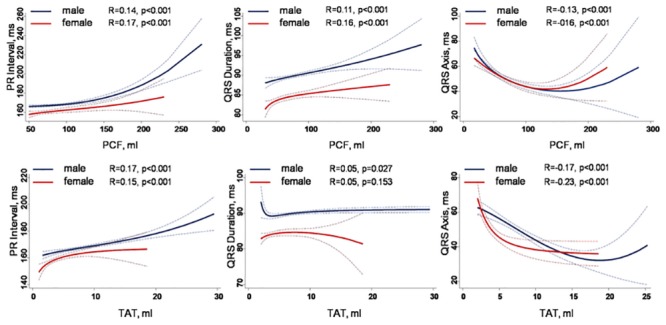
The associations between PCF or TAT on several electrocardiographic indices, including PR interval, QRS duration and QRS axes.No sex interactions were observed n these associations.